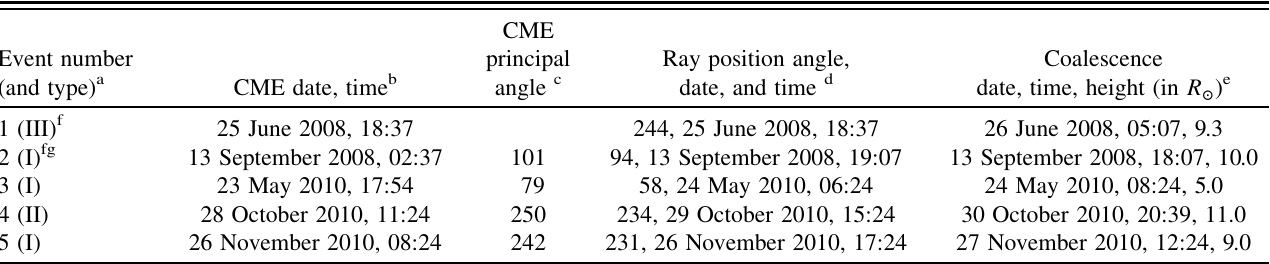
TABLE I. Candidates of blob-coalescence events as observed by the STEREO spacecraft from 1 January 2007 to 31 August 2011. Event